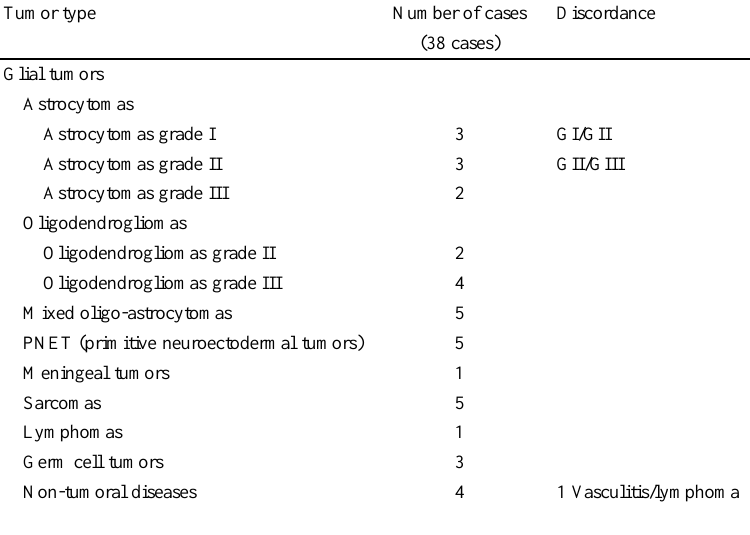
Diagnoses obtained using telepathology panel discussion Tumor type Number of